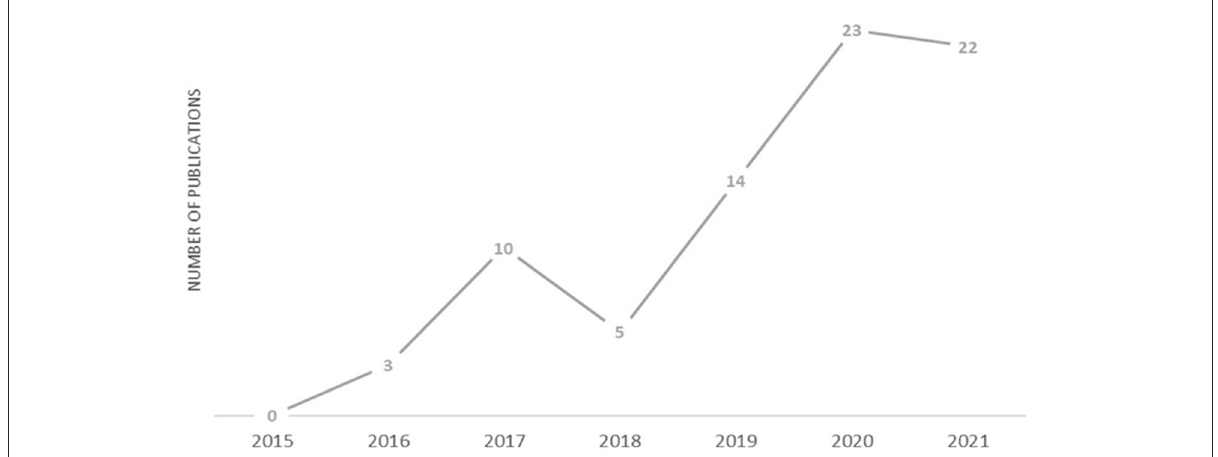
FIGURE2 Distribution of the filtered publications included in the analysis per year since